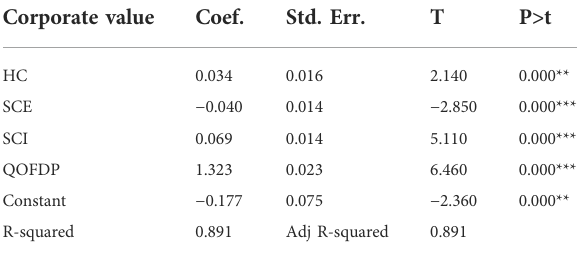
TABLE 4 Path assessment without moderators.